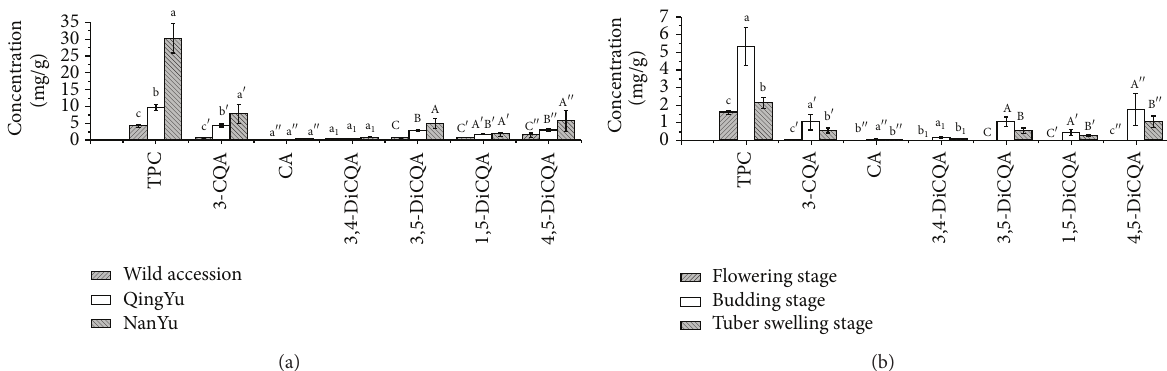
Figure 3: Concentration of phenolics in H. tuberosus leaves of different genotypes: (a) in 2011 and growth stages of cultivar NanYu (flowering stage, budding, and tuber swelling stages) and (b) from August to October in 2012. Concentrations were in mg/g dry weight of leaves. Values are expressed as mean ± SD of triplicate measurements; columns with the same letters are not significantly different according to Duncan’s test ( 𝑃 ≤ 0.05